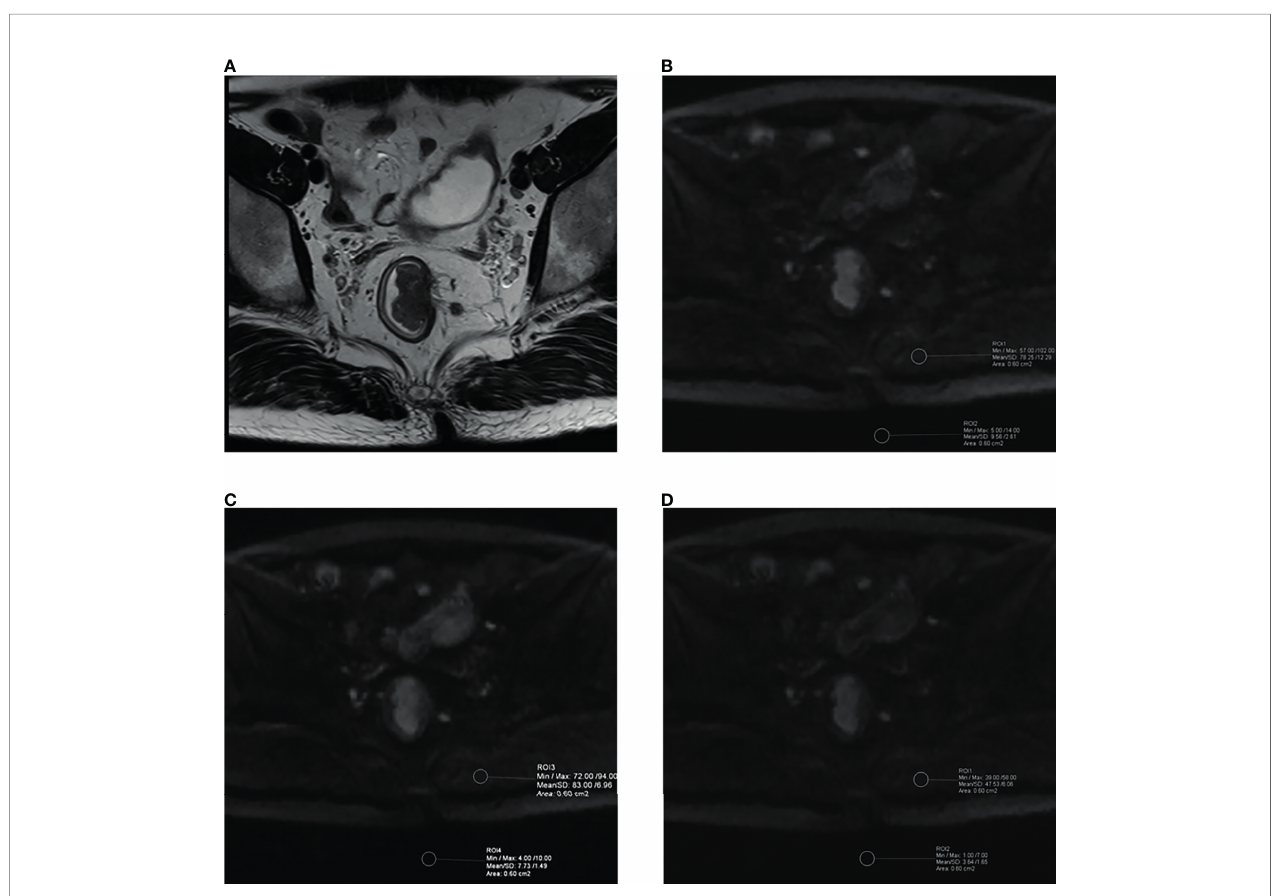
FIGURE 3 | Example images for delineating ROI and comparison between aDWI b1,000 and cDWI b1,000 images in a 39-year-old male patient with moderately differentiated rectal adenocarcinoma (T2 stage). (A) High-resolution T2WI exhibited irregular thickening of rectal wall. The aDWI b1,000 (B) , aDWI b700 (C) and cDWI b1,000 (D) images showed corresponding rectal wall with partially high signal intensity. The two circle ROIs were distributed in the background and gluteus maximus on the same slices and the same locations on both diffusion images to compute objective parameters. SNR, CNR and SIR were 147.67 vs. 257.90, 8.68 vs. 13.88 and 5.17 vs. 5.23 for aDWI b1,000 and cDWI b1,000 images, respectively. The cDWI b1,000 images achieved higher scores than aDWI b1,000 images by both readers in terms of subjective image parameters. aDWI b1,000 , acquired diffusion-weighted imaging with b-value of 0 and 1,000 s/mm 2 ; aDWI b700 = acquired diffusion- weighted imaging with b-value of 0 and 700 s/mm 2 ; cDWI b1,000 = computed diffusion images with b-value of 1,000 s/mm 2 from 0 and 700 s/mm 2